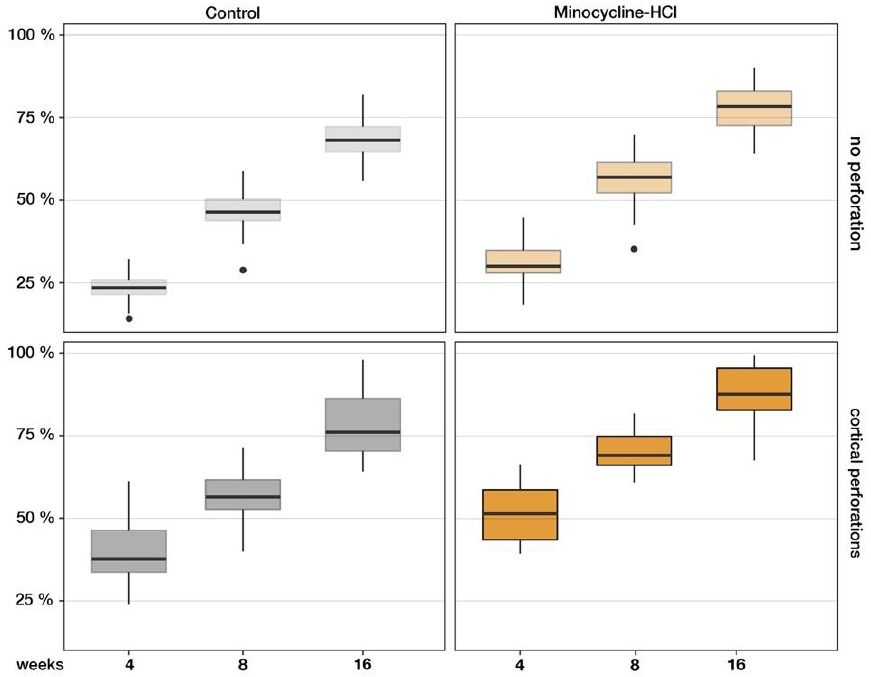
Figure 6. The ratio of mineralised tissues increased continuously in all control and test groups. After 4 months, the non-perforated specimens of the control group and test group MIN showed 68.4 ± 6.7% and 77.6 ± 9.5% mineralisation, respectively. The perforated caps of group P (77.9 ± 6.3%) and group MIN + P (87.2 ± 8.9%) produced the most new lamellar bone, indicating that the combination of marrow opening and systemic minocycline addition had an accelerating and enhancing effect on vertical bone augmentation in the rodent model.